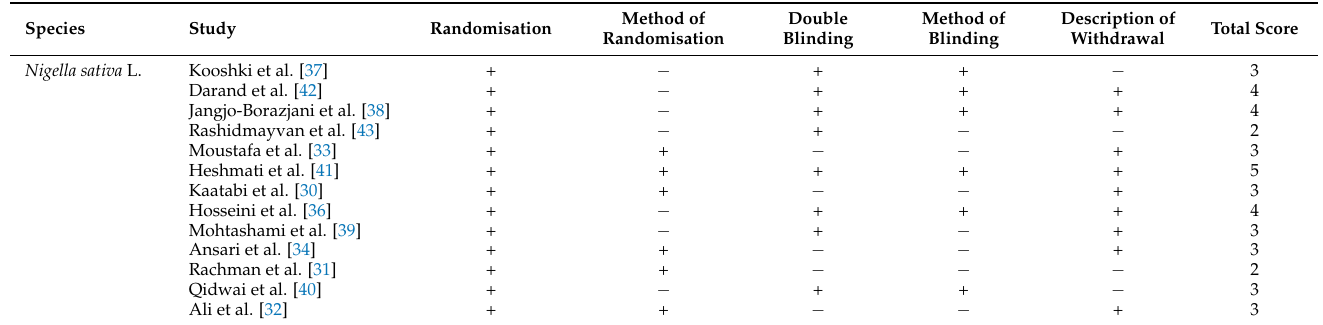
Table 3. Methodological quality scores for the randomised controlled studies using the Jadad scale. Study Randomisation Method of Randomisation Double